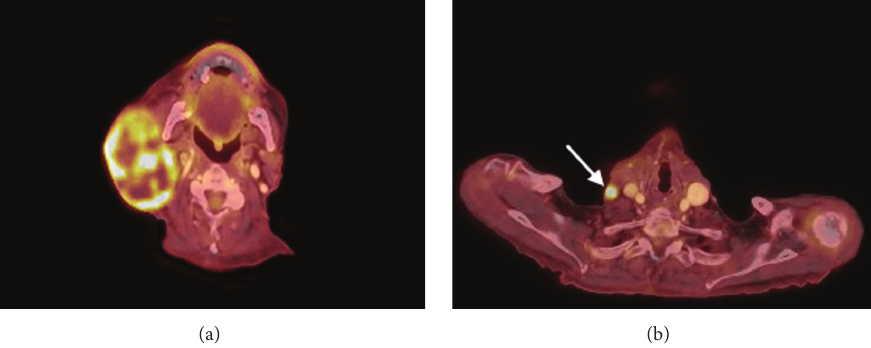
Figure 3: PET: axial images demonstrating FDG avidity in right parotid mass and extension to right subclavian